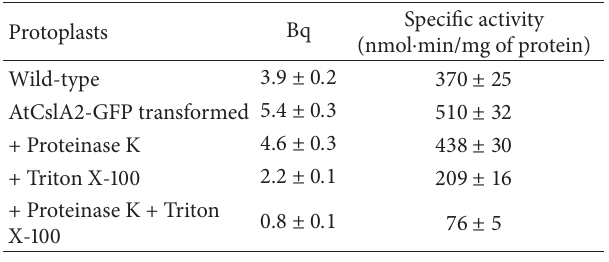
Table 1: Mannan synthase activity in wild-type and AtCslA2-GFP transformed tobacco protoplasts and effect of protease K with or without Triton X-100. The reaction mixture contained the following: